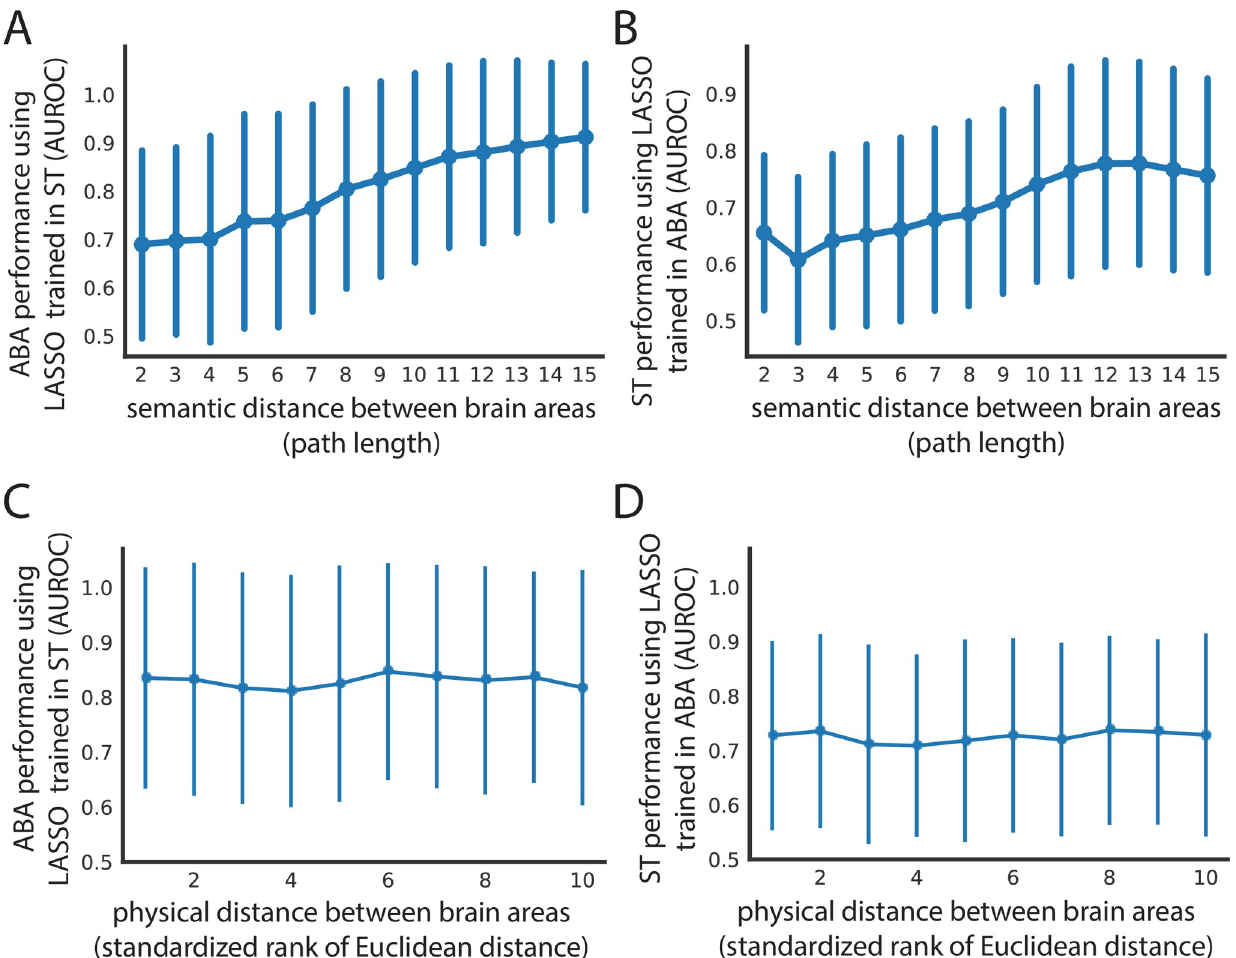
Fig 4. Spatial expression patterns reflect distance in semantic space, but not physical distance in the brain. Cross-dataset AUROCs (x-axis) of classifying all leaf brain areas from all other leaf brain areas for (A) ABA using LASSO (lambda = 0.1) trained in ST and (B) ST using LASSO (lambda = 0.1) trained in ABA as a function of path length (x-axis) in the ARA naming hierarchy between the 2 brain areas being classified. The same AUROCs (y-axis) from (A) and (B) shown in (C) and (D), respectively, as a function of minimum Euclidean distance between the 2 brain areas in the ARA (x-axis). Euclidean distance on the x-axis is binned into deciles for visualization. All 4 plots show mean AUROCs (points) with standard deviation (vertical bars). ABA, Allen Brain Atlas; ARA, Allen Reference Atlas; AUROC, area under the receiver operating curve; LASSO, least absolute shrinkage and selection operator; ST, spatial